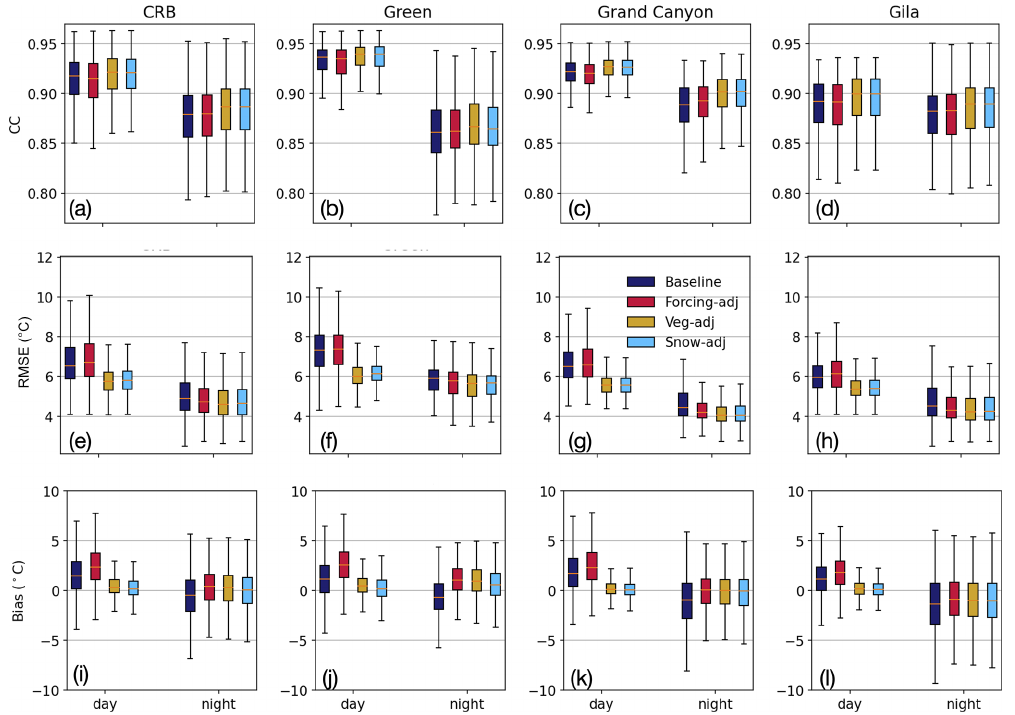
Figure 6. Box plots of (a–d) CC, (e–h) RMSE, and (i–l) bias between time series of LST V and LST M in pixels of the entire CRB and of three representative subbasins. Box plots show the median, with 50% and 90% confidence intervals. Different simulations are plotted in different